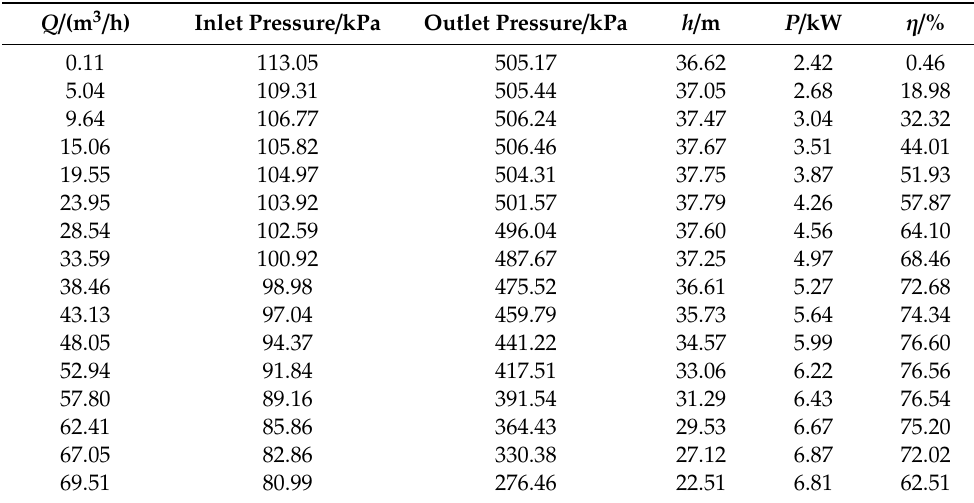
Table 4. Pump performance test results.